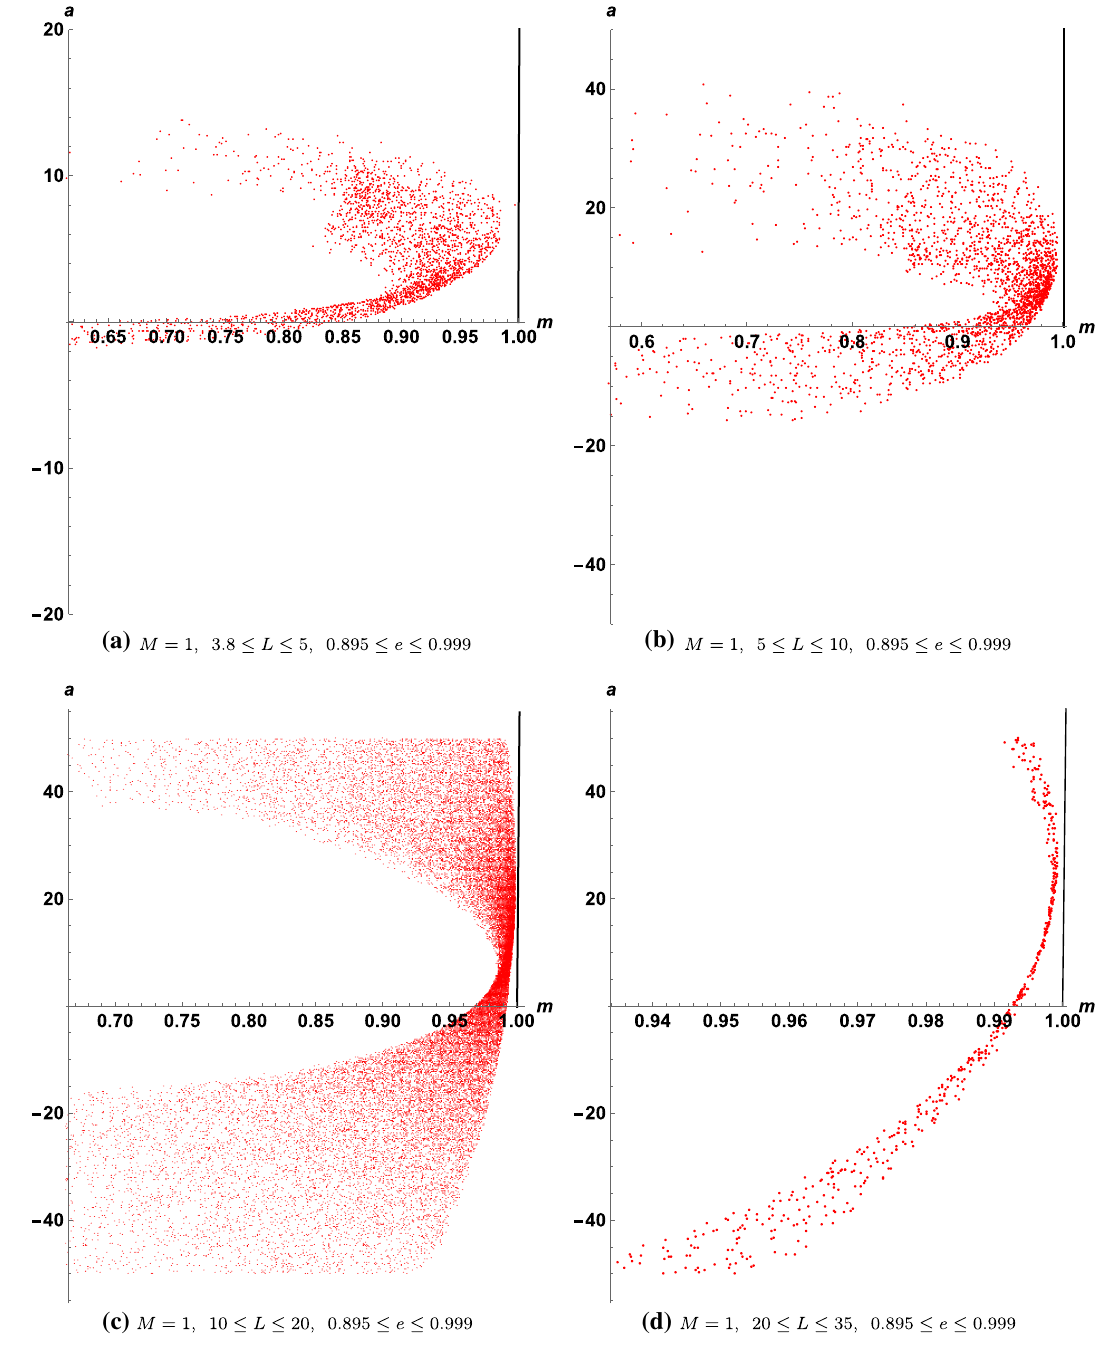
Fig. 3 The above figure shows the solution points for the timelike bound orbits in m and a coordinates. We have 0 < m < 1 and m > 1, that represent the positive precession and negative precession of timelike bound orbits